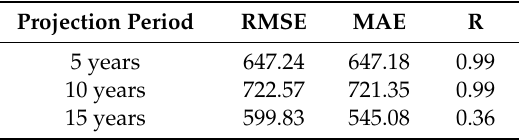
Table 1. Statistical results of the predictive accuracy.